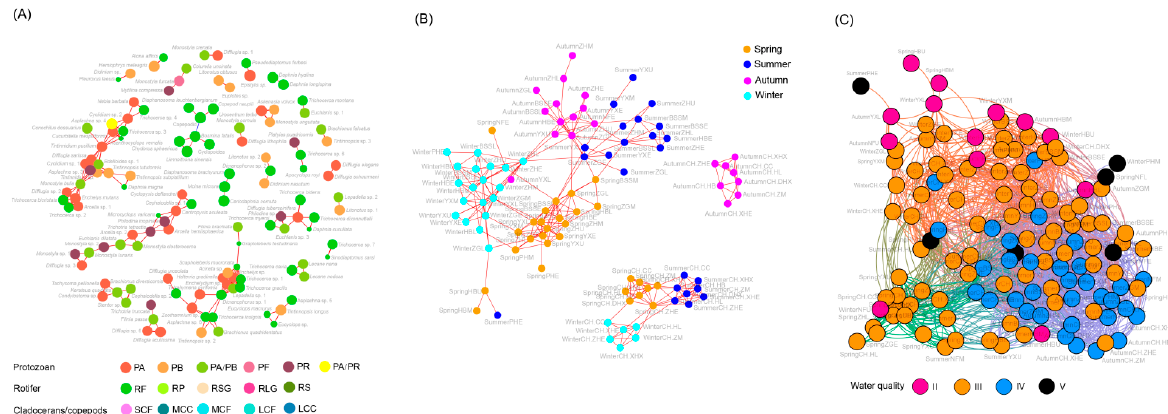
Figure 4. Co-occurrence network of zooplankton species ( A ) and sampling sites based on zooplankton species ( B ) and based on zooplankton functional groups ( C ) in Chaohu Lake Basin. Different colors in panel ( A ) indicate different zooplankton functional groups. Different colors in panels ( B ) and ( C ) indicate different seasons. The red and blue edges indicate significant positive correlation (Spearman correlation coefficient > 0.6 and p < 0.05) and significant negative correlation (Spearman correlation coefficient < − 0.6 and p < 0.05), respectively. The circle diameters in panel ( A ) indicate the relative abundance of the zooplankton species.